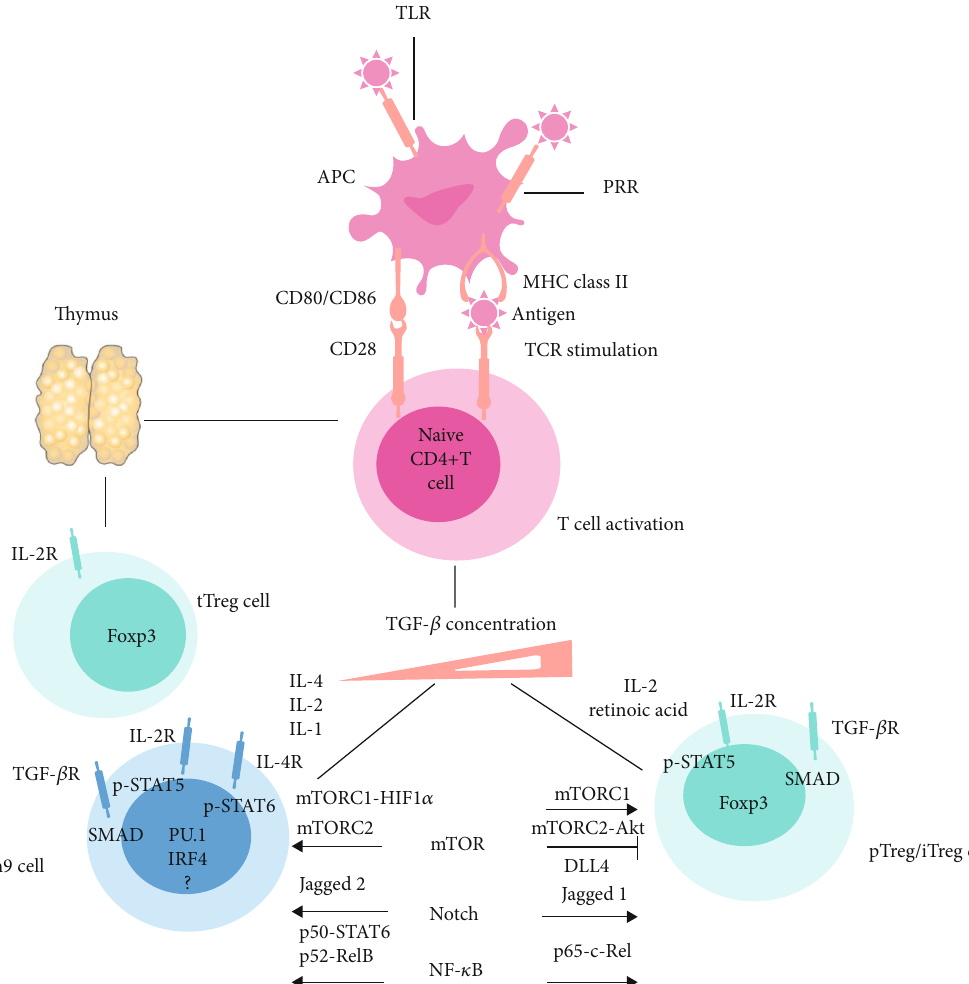
Figure 3: The reciprocal developmental pathways for the generation and di ff erentiation of Th9 cell and Treg cell. The thymic Treg (tTreg) cell arises in the thymus. Transcription factor PU.1, IRF4, and Foxp3 are essential for di ff erentiation of Th9 and Treg cell subsets, respectively. The local microenvironment strongly in fl uences the processes that determine lineage di ff erentiation of Th9 cell and Treg cell. Binding of conserved pathogen-derived molecules to pattern recognition receptors (PRRs) such as Toll-like receptors (TLRs), on the cell surface of APCs activates the production of various cytokines. Activated APCs present antigens to naïve CD4 + T cell and promote di ff erentiation of Th9 cell and Treg cell. The presence of high concentration of TGF- β in combination with IL-2 and retinoic acid (RA) is optimal for Foxp3 expression to facilitate periphery Treg (pTreg) cell or inducible Treg (iTreg) cell generation. By contrast, low concentration of TGF- β in combination with IL-4 and IL-2 induces di ff erentiation of Th9 cell through induction of STAT6 and STAT5. In addition, IL-1 β combined with IL-4 induces a Th9 IL-4+IL-1 β cell subset. Di ff erent signaling pathways including the mechanistic target of rapamycin (mTOR), Notch, and NF- κ B signals are also required for the regulation of development and di ff erentiation of Th9 cell and Treg